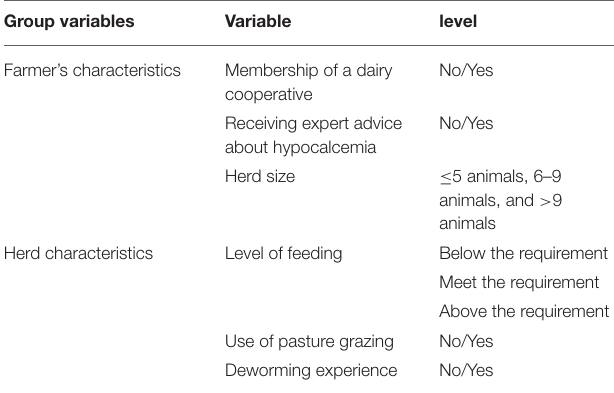
TABLE 1 | Herd-level variables potentially related to subclinical hypocalcemia in dairy farms of North-West Ethiopia as included in the